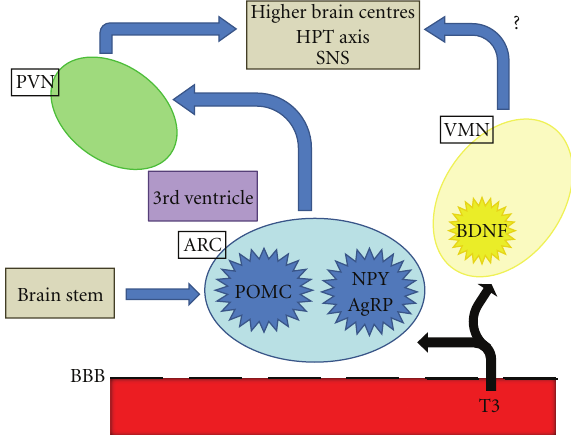
Figure 1: Schematic diagram of central appetite regulation. T3 can access the hypothalamus and brainstem via the incomplete blood brain barrier. PVN: paraventricular nucleus; ARC: arcuate nucleus; VMN: ventromedial nucleus; BBB: blood-brain barrier; T3: triiodothyronine; POMC: Pro-opiomelanocortin; NPY: neu- ropeptide Y; AgRP: agouti-related protein; BDNF: brain-derived neurotrophic factor; HPT: hypothalamic-pituitary thyroid; SNS: sympathetic nervous system.